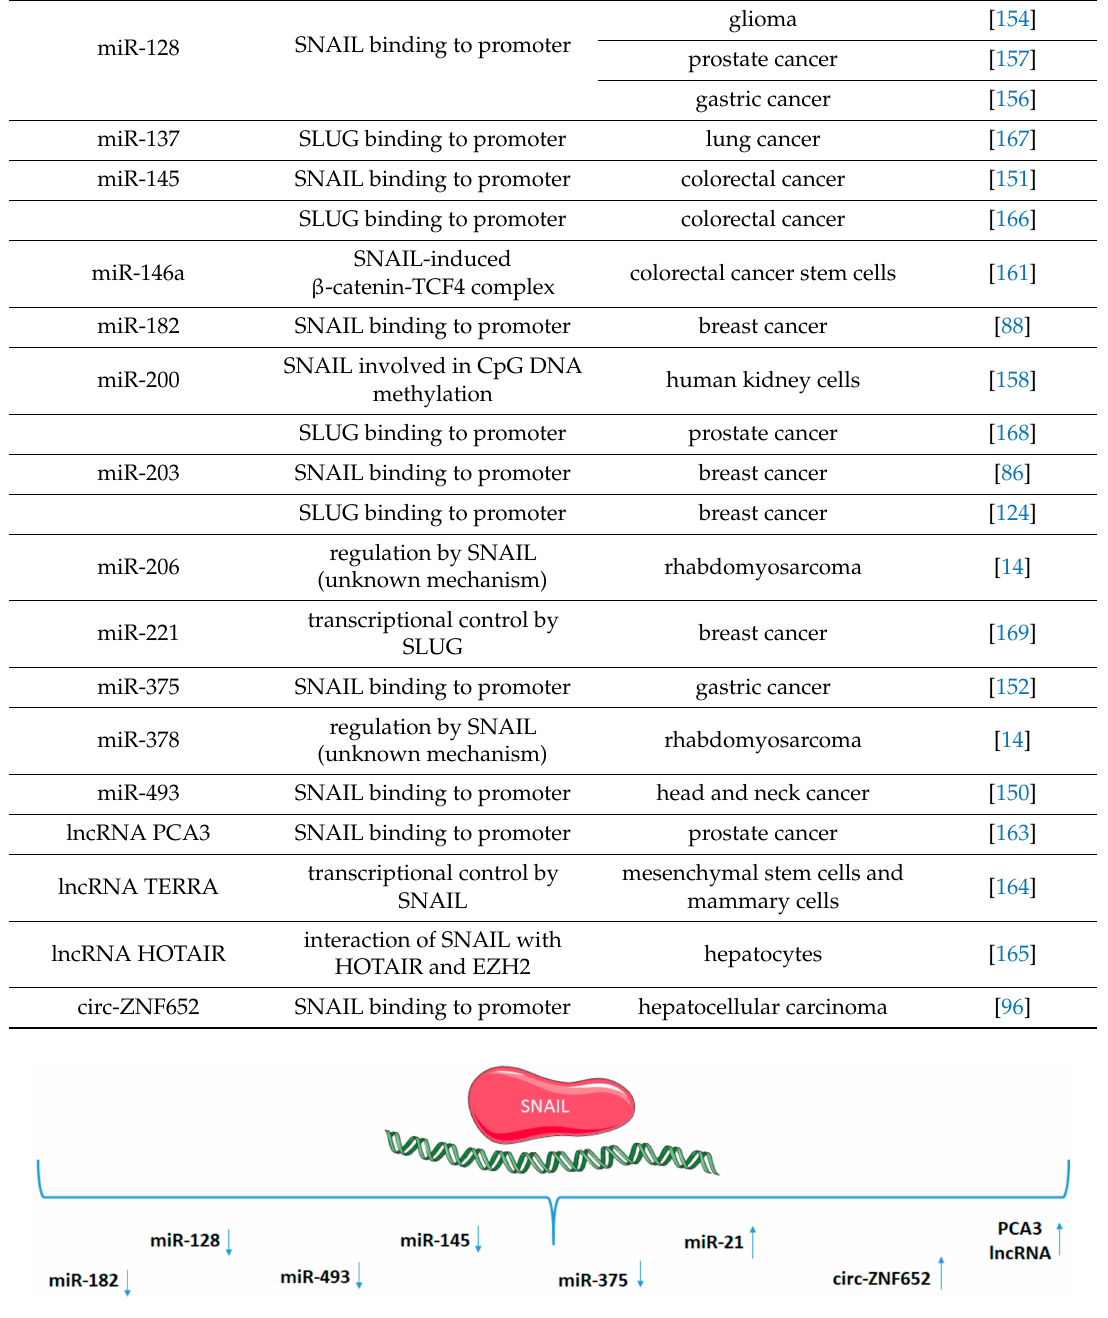
Figure 4. MiRNAs, long non-coding RNAs (lncRNAs), and circular RNAs regulated directly by SNAIL transcription